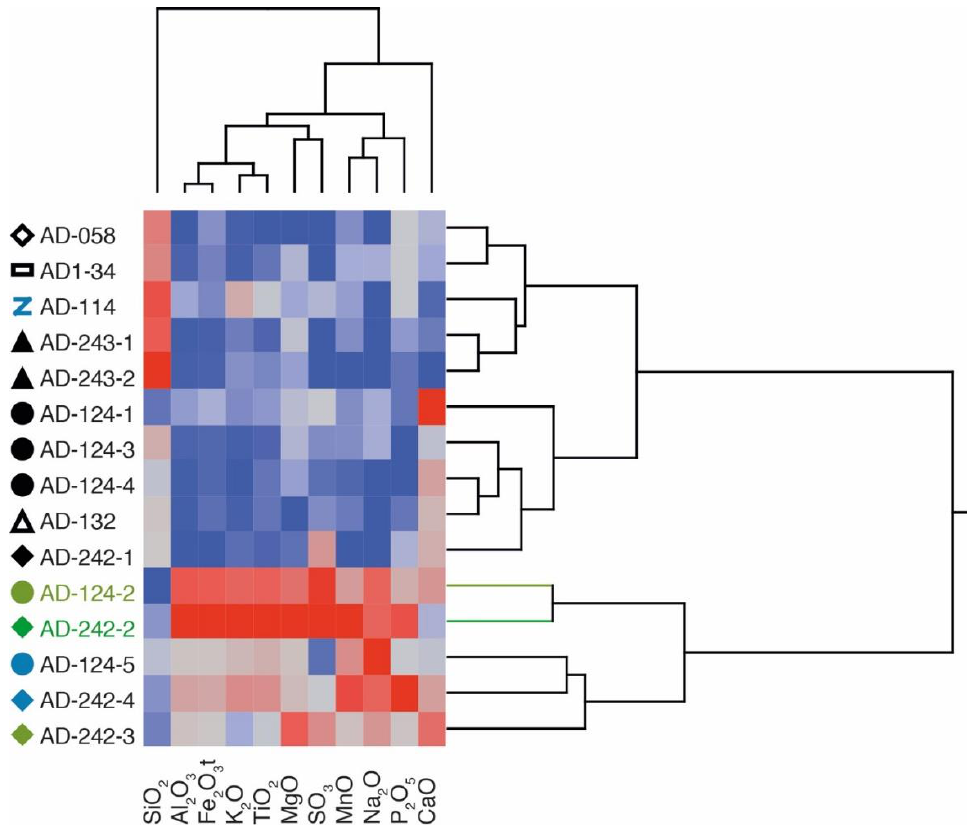
Figure 7. Dendrogram of the mortars according to their layers. Green symbols correspond to layers with ceramic fragments. Blue symbols correspond to clay-rich layers and sandy-clayey layer.